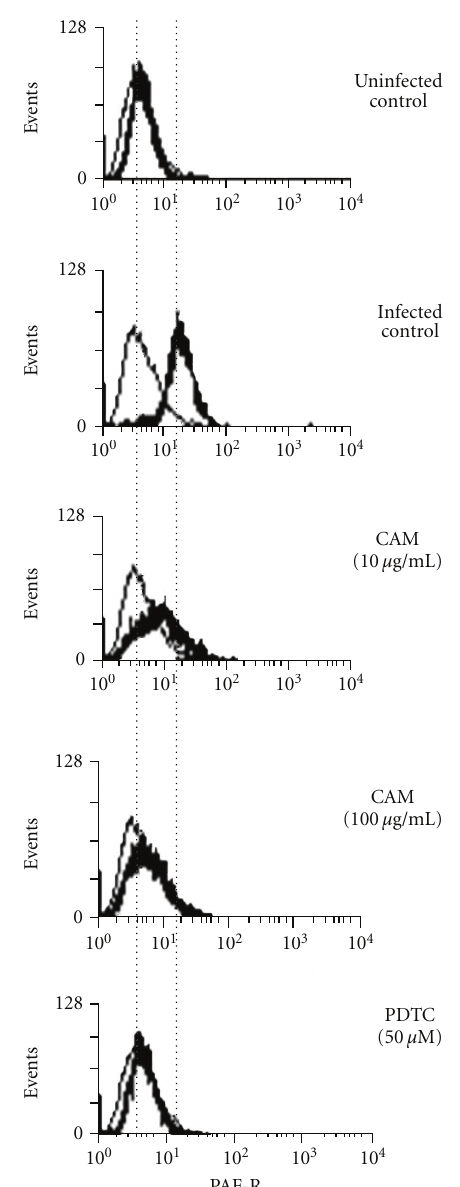
Figure 3: E ff ect of CAM and PDTC on RSV-induced PAF receptor expression in A549 cells. One hour before RSV infection, CAM or PDTC is added to A549 cell culture at the indicated concentration. The cells were infected with the RSV at MOI of 1. After 24h of infection, the cells were collected and then stained with an anti- PAF receptor antibody and phycoerythrin-labeled anti-mouse IgG antibody (thick lines). The stained cells were analyzed by flow cytometry. Thin lines indicate the cells stained with an unrelated isotype control antibody instead of the anti-PAF receptor